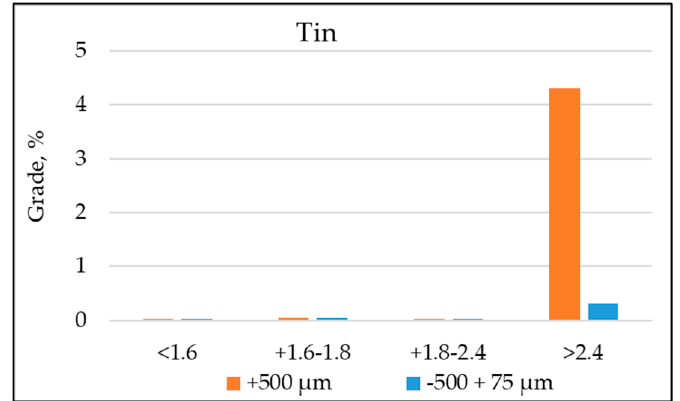
Figure 3. Metal content in different specific gravity fraction of the coarse and fine sample.